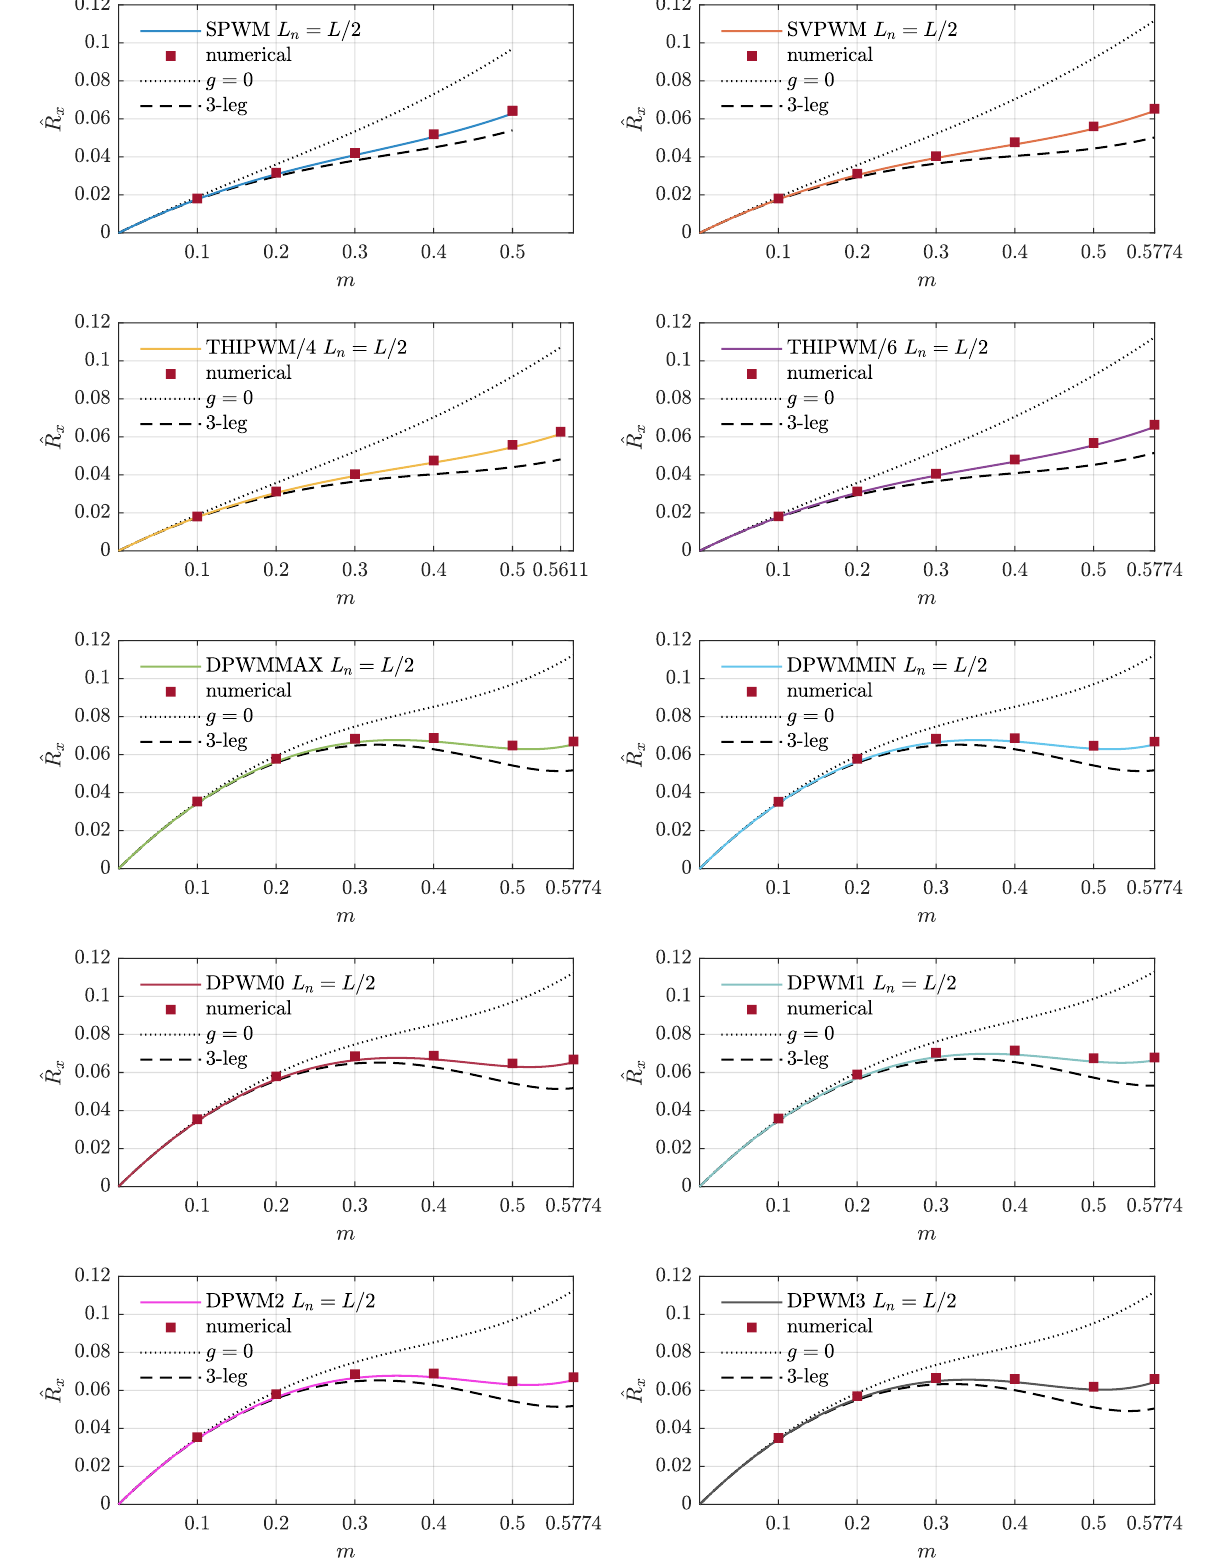
Figure 3. Numerical validation of normalized phase-current-ripple RMS in the case of multiple PWM common-mode injections for L n = L /2 (i.e., g = 0.5). Normalization base V dc / ( 2 Lf sw )